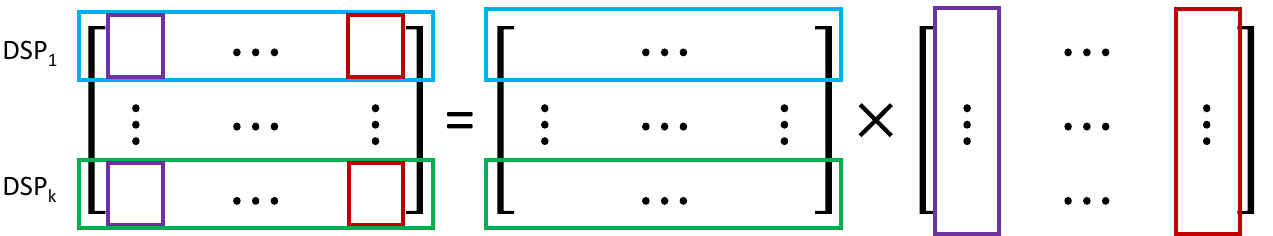
Figure 8. Splitting of the rightmost matrix on vertical blocks and the leftmost matrix on strips for parallel processing.